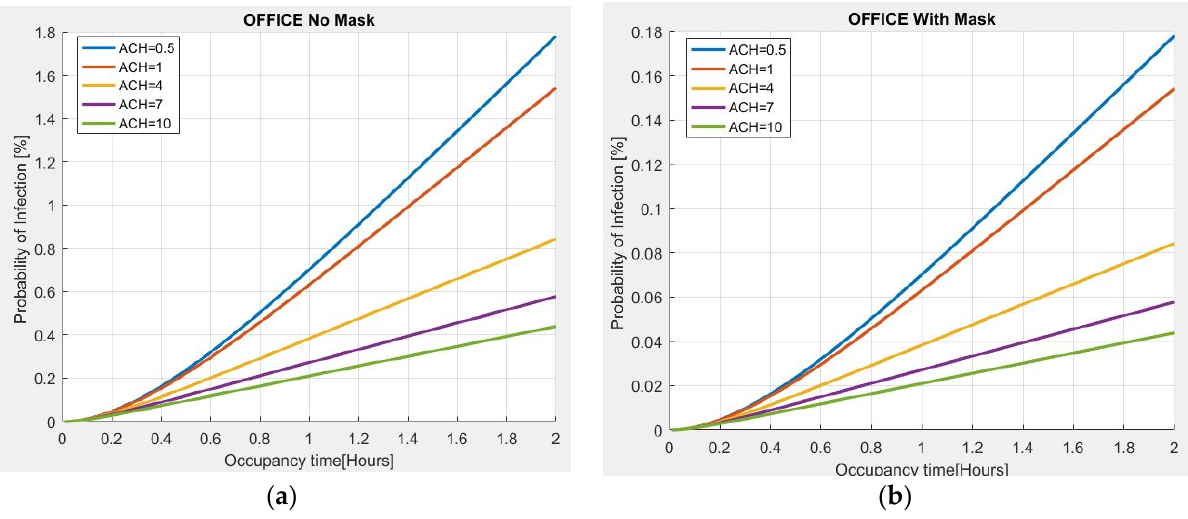
Figure 5. Probability of infection vs. permanence time for different ACH values in an office: ( a ) without mask; ( b ) with mask.